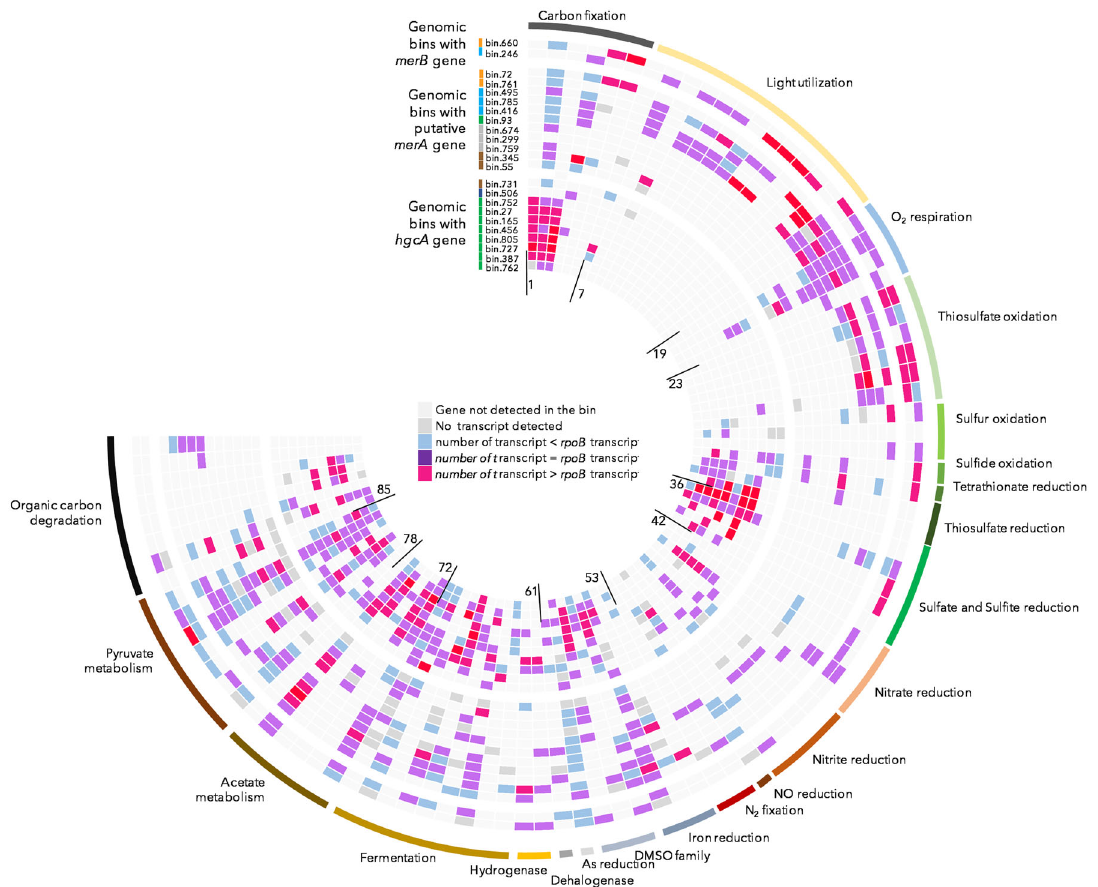
Fig. 7 Gene expression pro fi le of genomic bins potentially involved in mercury transformations. For each bin, all transcripts identi fi ed per gene over the different sampling periods were summed, then the summed number of transcripts per gene was compared to the number of rpoB gene transcripts to determine the relative expression level. List of the genes and associated dataset is provided in Supplementary Data